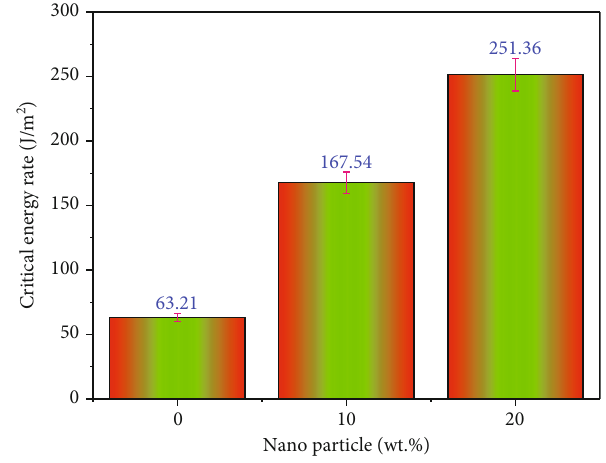
Figure 5: Critical energy of coir/pineapple/Al